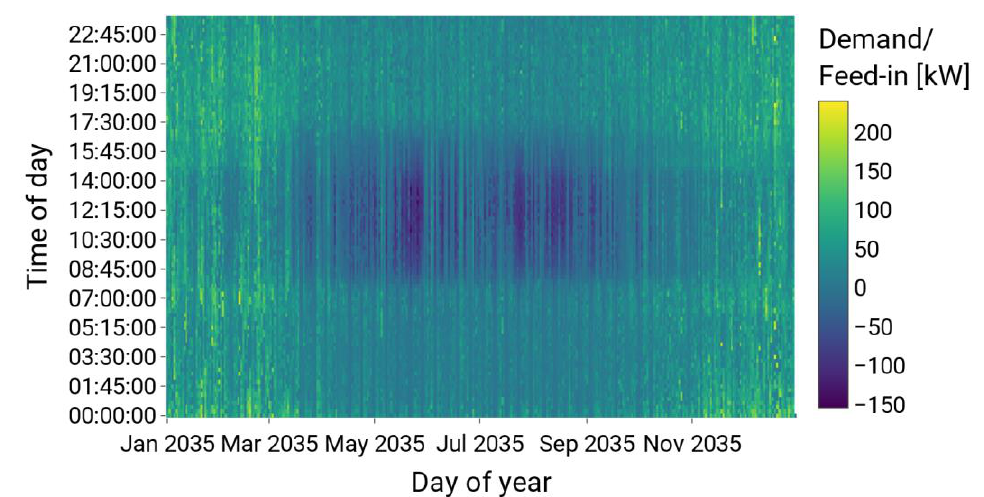
Figure A2. Heatmap of the electric demand (positive values) and feed-in (negative values) for the flat participant fee scenario, the scenario year 2035 and the rural grid.